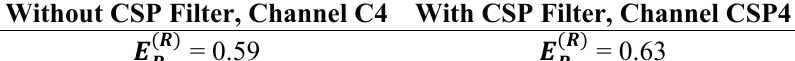
Table 1. A comparison of the proportional energy between classes with and without the CSP